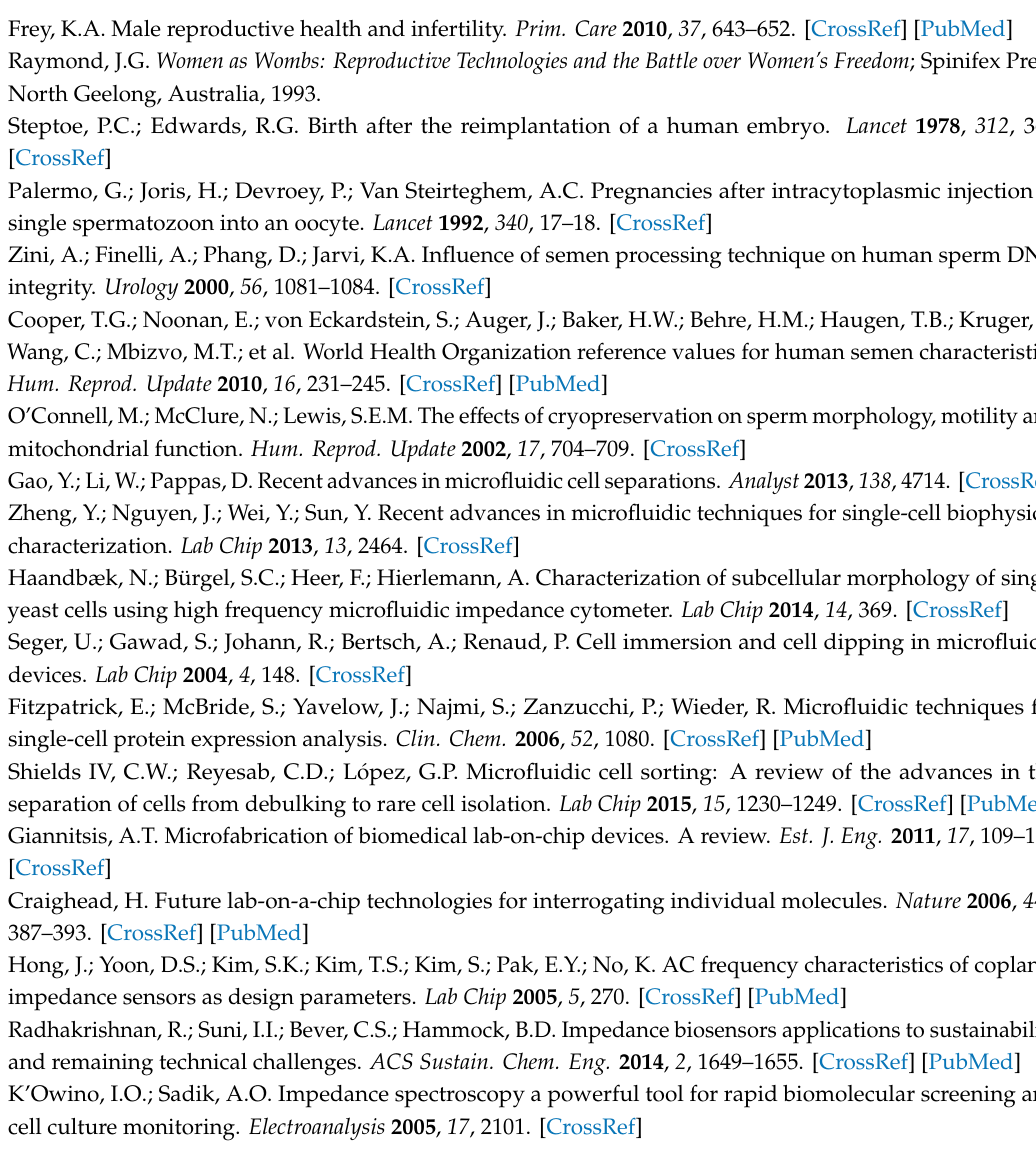
Supplementary Materials: The following are available online at http: // www.mdpi.com / 2072-666X / 10 / 10 / 647 / s1, Figure S1: GUI of RLC measurement